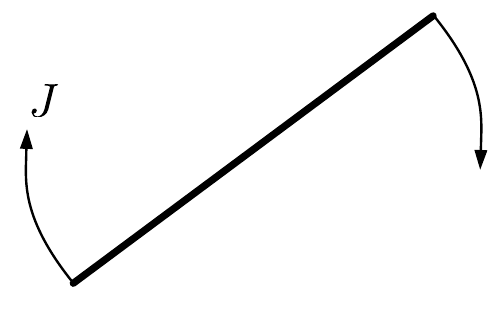
Figure 1 . Open string rotating with angular momentum